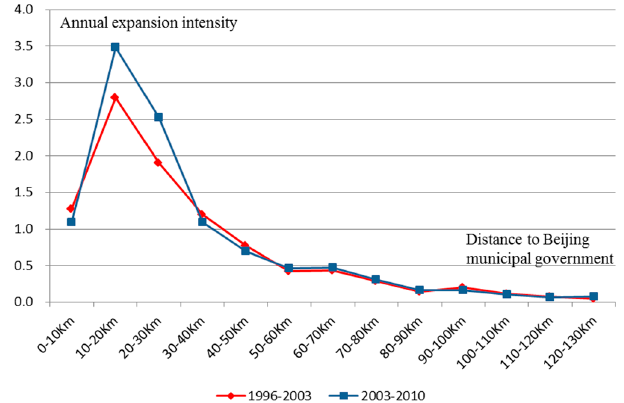
Figure 7. Annual expansion intensity in buffer rings around the municipal government in Beijing.